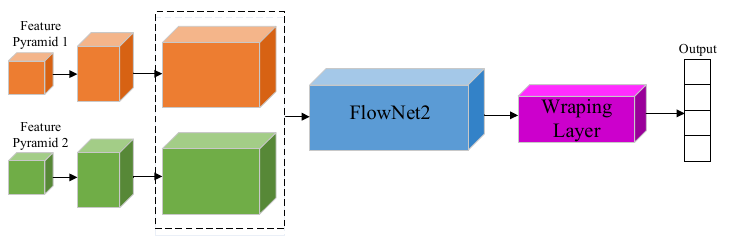
Figure 2. Architecture for Optical Flow Motion Estimation.